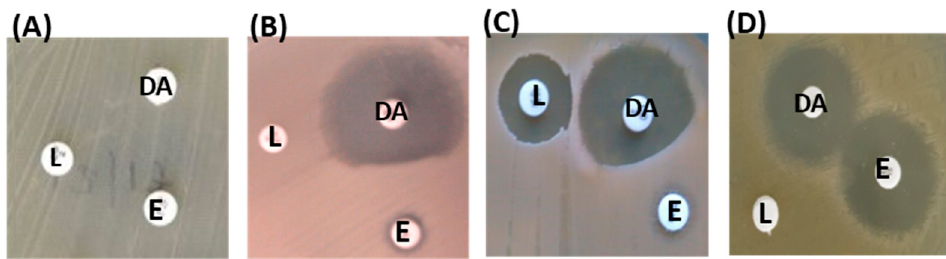
Figure 4. MLS resistance phenotypes. The inhibition zones to erythromycin (E), clindamycin (DA), and lincomycin (L) were observed. ( A ) Constitutive macrolide/lincosamide/streptogramin resistance (cMLS) phenotype: isolates resistant to the three drugs. ( B ) Inducible macrolide/lincosamide/streptogramin resistance (iMLS) phenotype: isolates show flattening or blunting of the shape of the clindamycin zone and are resistant to erythromycin and lincomycin. ( C ) M phenotypes: isolates resistant to erythromycin only but sensitive to clindamycin and lincomycin. ( D ) L phenotype: isolates resistant to lincomycin and sensitive to clindamycin and erythromycin. E: erythromycin, DA: clindamycin, and L: lincomycin. Table 2. MLS phenotypes.